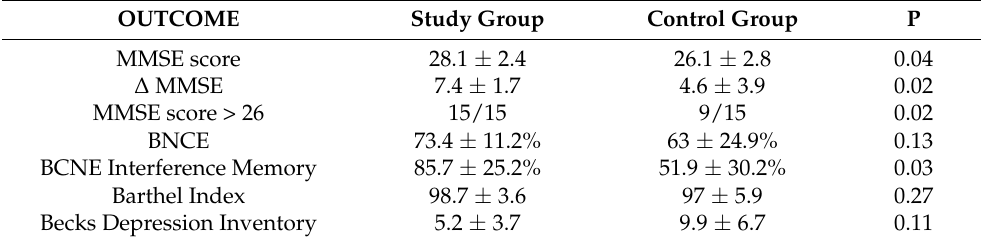
Table 3. Cognitive and Independency Outcome for 180 d after